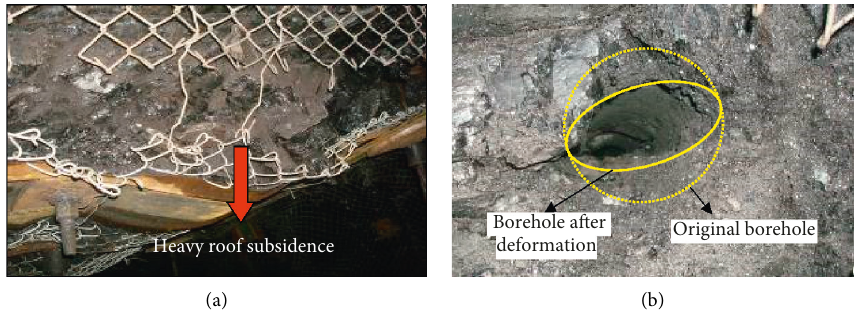
Figure 3: Field photos of rail groove in working face (4-5)04: (a) heavy roof subsidence; (b) Borehole Deformation.